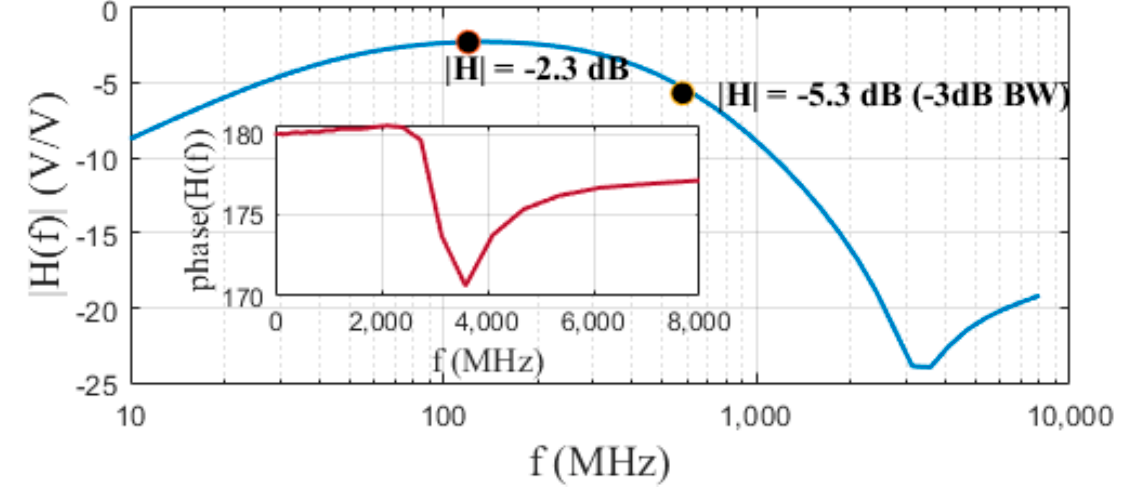
Figure 12. Low-pass filter transfer function: Magnitude (blue) and phase (inset).